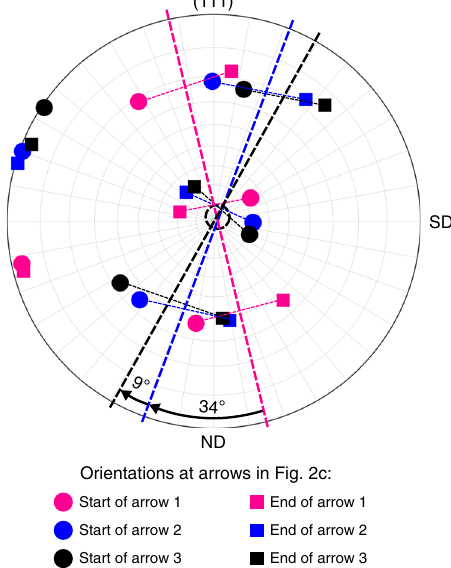
Fig. 4 Compatibility analysis of shearing and crystal rotation processes as re fl ected by the TB. (111) pole fi gure of orientations left (dot) and right (square) of the TB at arrows 1 (magenta), 2 (blue), and 3 (black) depicted in Fig. 2c. The (manually drawn) dotted lines demark the approximate location of the corresponding twin planes. Their spatial alignment closely matches that of the corresponding TB segments in Fig. 1. The rotations between magenta and blue lines (~34°) as well as blue and black lines (~9°) roughly match the corresponding misorientations at lower and upper DTL as seen in Fig. 2c. The intersection of the three twin plane lines (black circle, manually drawn) shows that the common rotational axis is close to TD (center of the PF). Shearing and crystal rotation processes are both re fl ected by the TB without